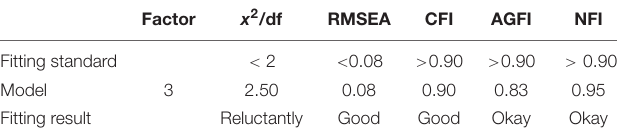
TABLE 2 | Validity analysis results of the model.